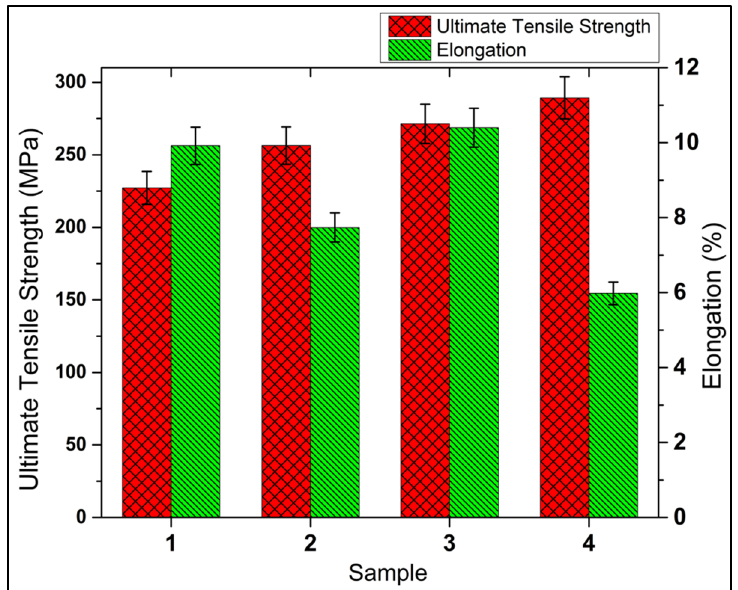
Figure 10. Average valves of ultimate tensile strength and percentage elongation of: AA7075 (base alloy, sample 1), AA7075-5wt %SiC (MMC, sample 2), AA7075-5wt %SiC-3wt %RHA (s-HMMC, sample 3) and AA7075-5wt %SiC-3wt %RHA-1wt %CES (n-HMMC, sample 4).